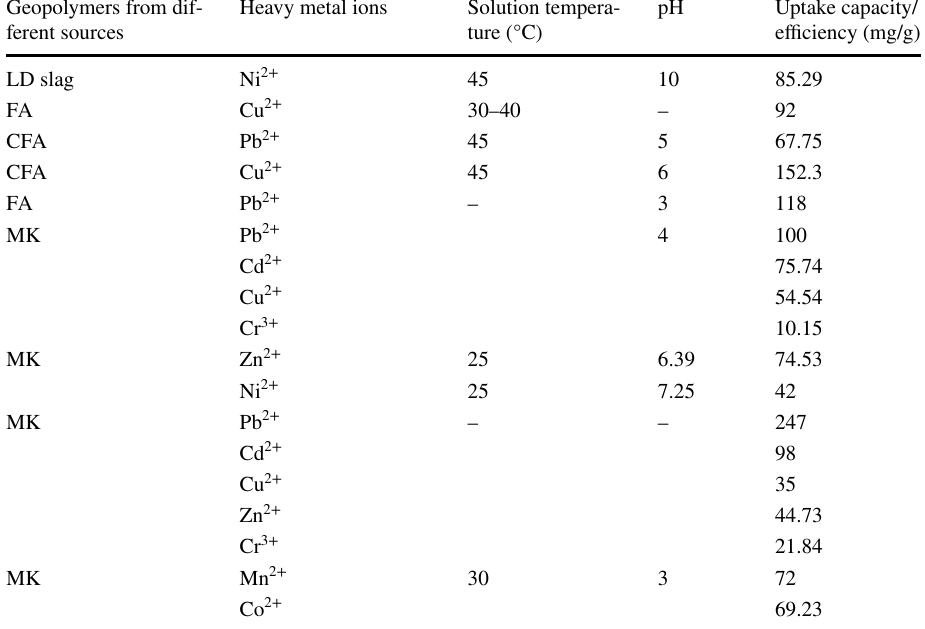
Table13 Removal of heavy metals by geopolymers (Tan Tee et al.